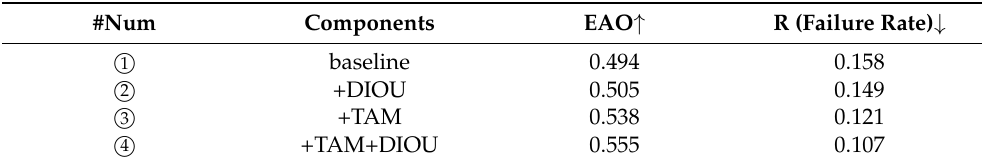
Table 4. Components analysis of TA-Siam. “TAM” represents template adjustment module, “DIOU” means distance-IOU